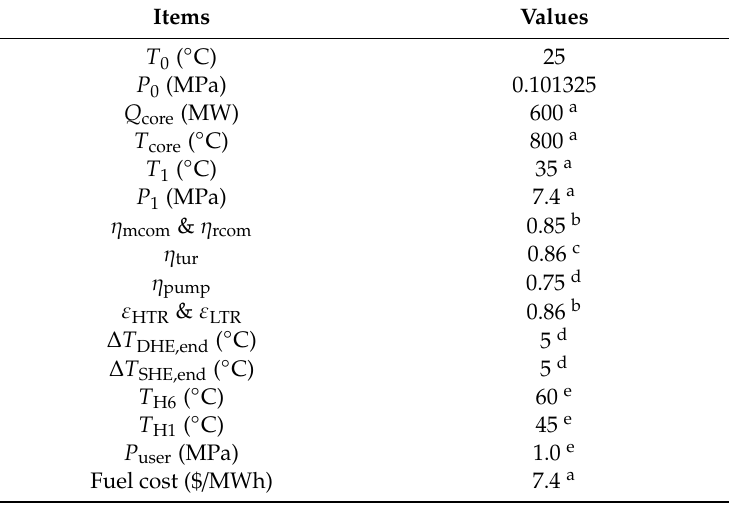
Table 9. The main input conditions for the